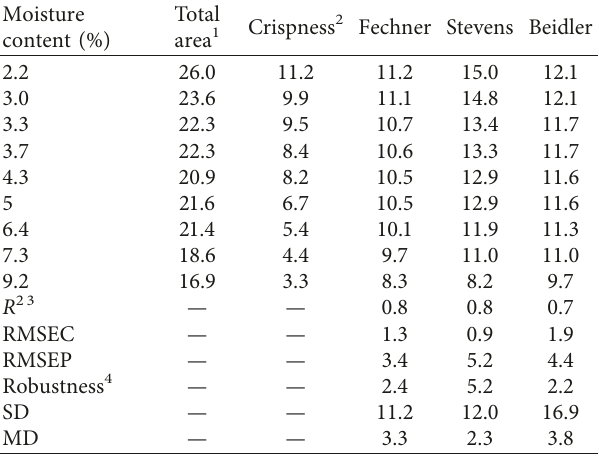
Table 4: Observed and predicted values of crispness intensity by psychophysical models and their model statistics. Moisture content